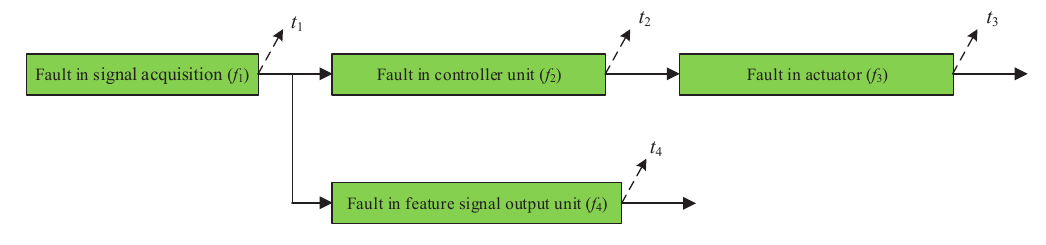
Figure 2. The dependency model of a control